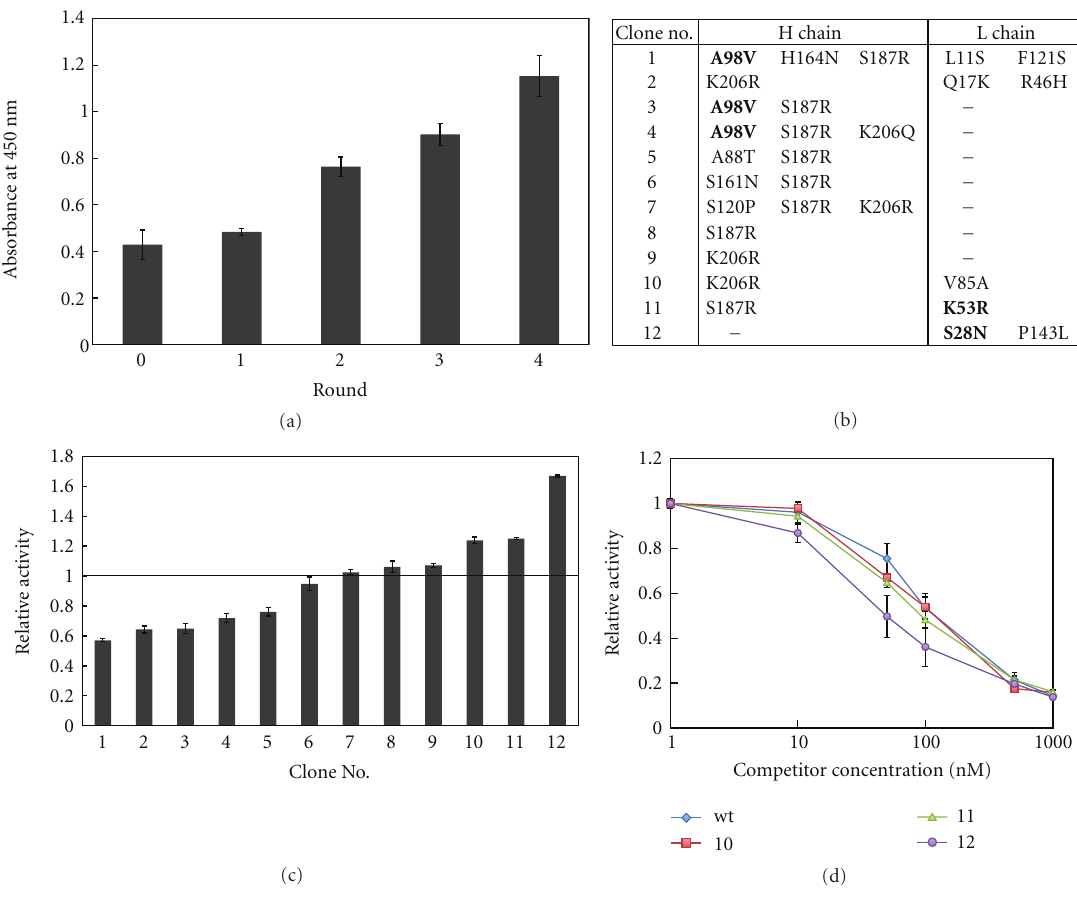
Figure 4: A ffi nity selection of randomly mutated anti-p53 Fab fragments. (a) Binding activity of the library after each round of selection. Random mutations were introduced to anti-p53 Fab fragments and 4 rounds of a ffi nity selection were carried out under decreasing antigen concentration (round 1, 400 nM; round 2, 40nM; round 3, 4nM; round 4, 0.4nM). After each round of selection, the fraction of the mutant Fab fragment library that binds to p53 was monitored by ELISA. Round 0 represents the randomly mutated initial library before selection. (b) Amino acid mutations of the selected variants. Bold type represents the mutations in the CDR and the minus ( − ) represents no amino acid mutations. (c) Binding activity of the selected variants after the 4th round of selection. The antigen binding activities of the selected variants were measured by ELISA. The absorbance at 450 nm of the wild type was used for normalization. (d) Competitive ELISA for estimating their a ffi nities of variants with higher binding activity than the wild type. Competitive ELISA was preformed with 0–1000 nM free p53 for clone number 10–12 and the wild type (wt). The signals were normalized to that of 0nM competitor